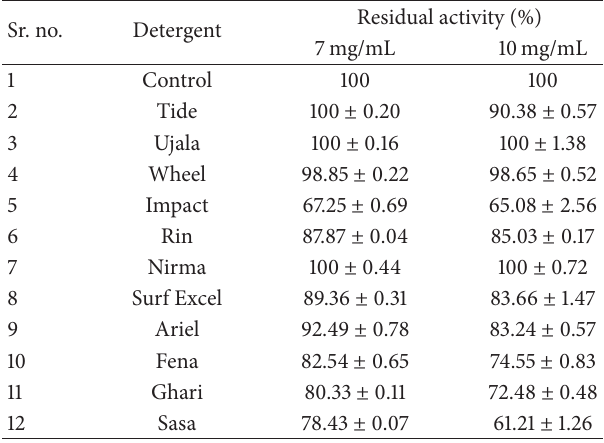
Table 3: Stability of protease enzyme preparation in various local detergents.